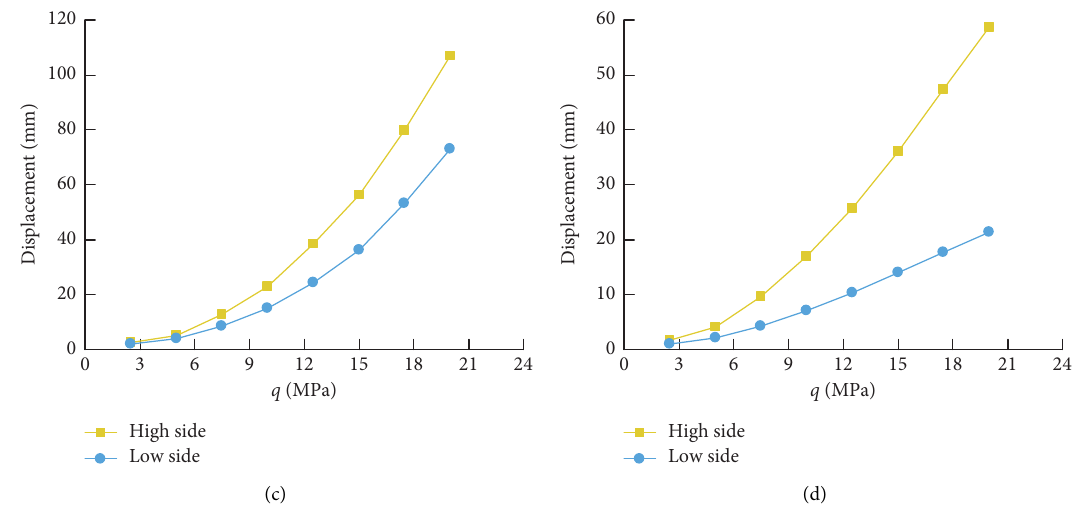
Figure 10: Analysis curves of the horizontal displacements of the two sides of the roadway. (a) 18 ° . (b) 21 ° . (c) 24 ° . (d) 27 ° . Table 3: Horizontal displacement of two sides of roadway (mm). Ground stress 10MPa Ground stress 20 Dip angle